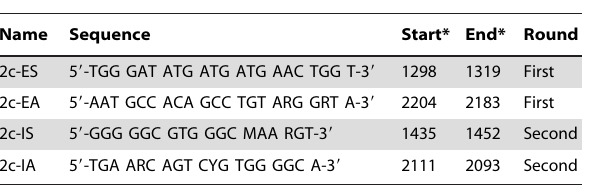
Table 1. HCV Subtype 2c E2